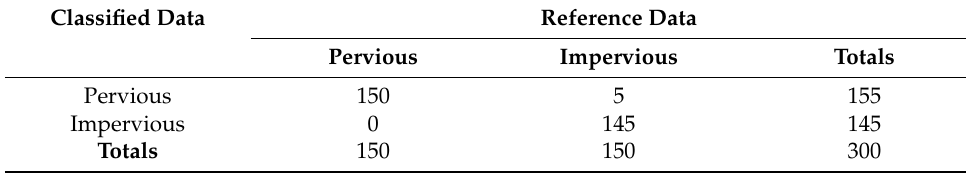
Table 6. 2014 Error (confusion)